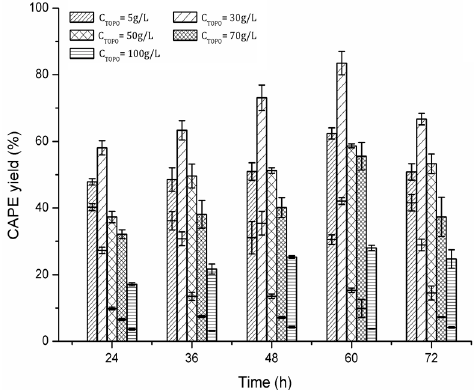
Figure 4. Effect of TOPO concentration in cyclohexane on the yield of CAPE in TOPO-cyclohexane/[Bmim][Tf 2 N] (1:1, v / v ). The upper histogram shows the yield of CAPE in TOPO-cyclohexane phase; the lower histogram shows the yield of CAPE in the IL phase; and the total CAPE yield is the sum of upper and lower yields. Conditions: mass ratio of MC to Novozym 435 = 1:20, molar ratio of MC to PE = 1:15, MC concentration = 10 g/L, temperature = 80 °C. Each value is expressed as the mean ± standard deviation ( n = 3).